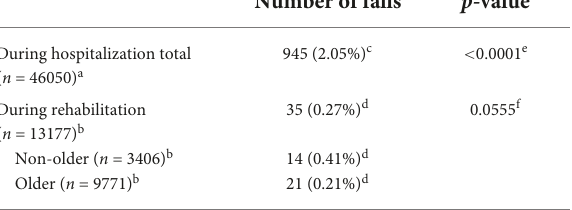
TABLE 1 Number of falls occurring during hospitalization and rehabilitation.